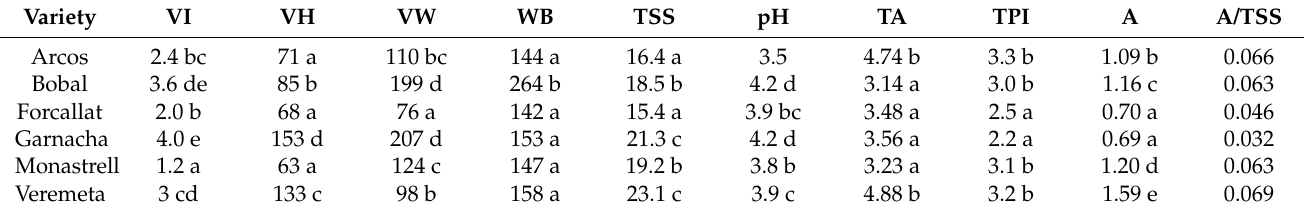
Table 2. Agronomic- and quality-related traits for Arcos, Bobal, Garnacha, Forcallat, Monastrell, and Veremeta